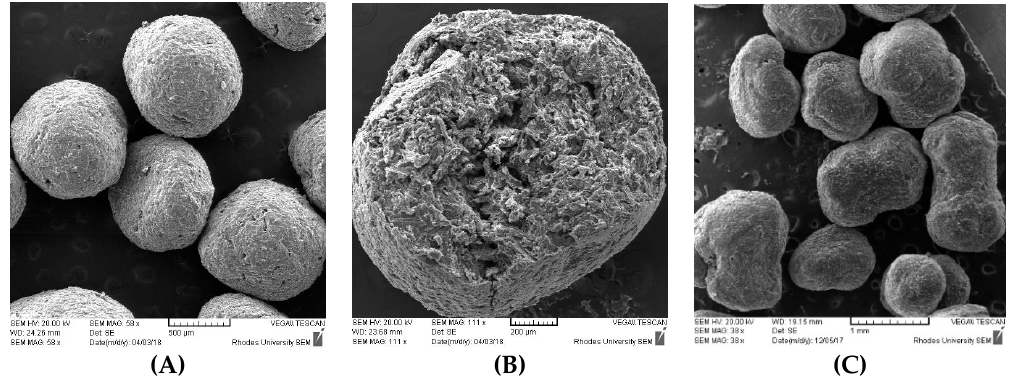
Figure 6. SEM images for the ( A ) optimized formulation; ( B ) cross section of the optimized formulation revealing a porous internal structure; and ( C ) elongated, irregular, non-uniform and dumb-bell shaped pellets for formulation 12.